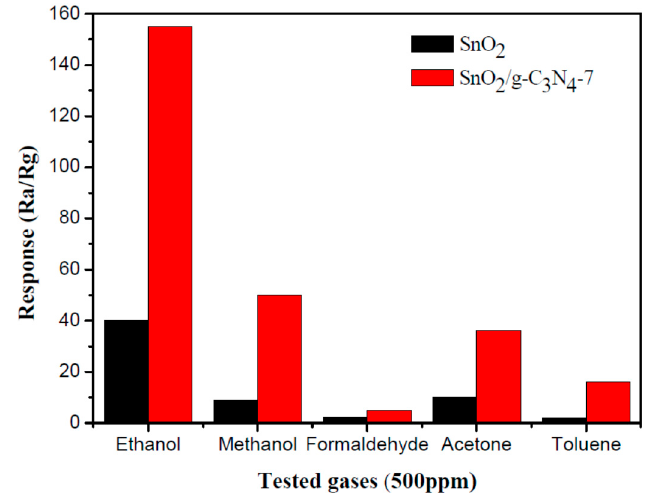
Figure 8. Comparision of the response values of the flower-like SnO 2 nanorods and the SnO 2 /g-C 3 N 4 -7 composite toward 500 ppm different gases at 340 °C.